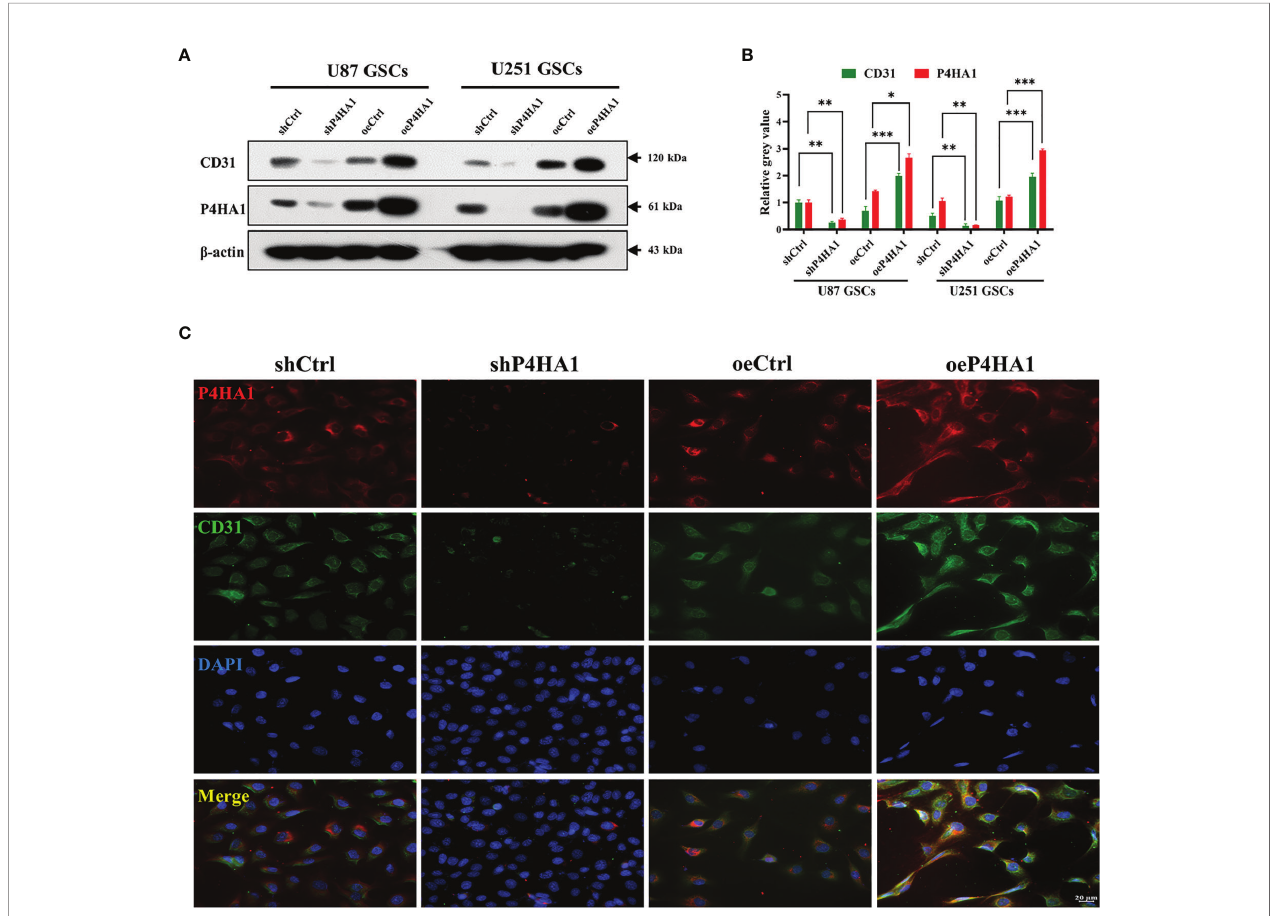
FIGURE 2 | Transdifferentiation of GSCs with different P4HA1 expression levels. (A) Western blot analysis showing that CD31 expression was encouraged by the P4HA1 expression level in both U87 and U251 GSCs in the hypoxic transdifferentiation process. (B) Gray calculation of (A) . The gray value of each band was divided by the corresponding gray value of the actin band. All results were normalized to the gray value of the band of U87 GSCs transfected with shCtrl. *P < 0.05, **P < 0.01, ***P < 0.001. (C) Immuno fl uorescence assays showing that P4HA1 expression was positively correlated with CD31 expression in U251 GSCs after 72 hours hypoxic transdifferentiation (scale bar=20 m